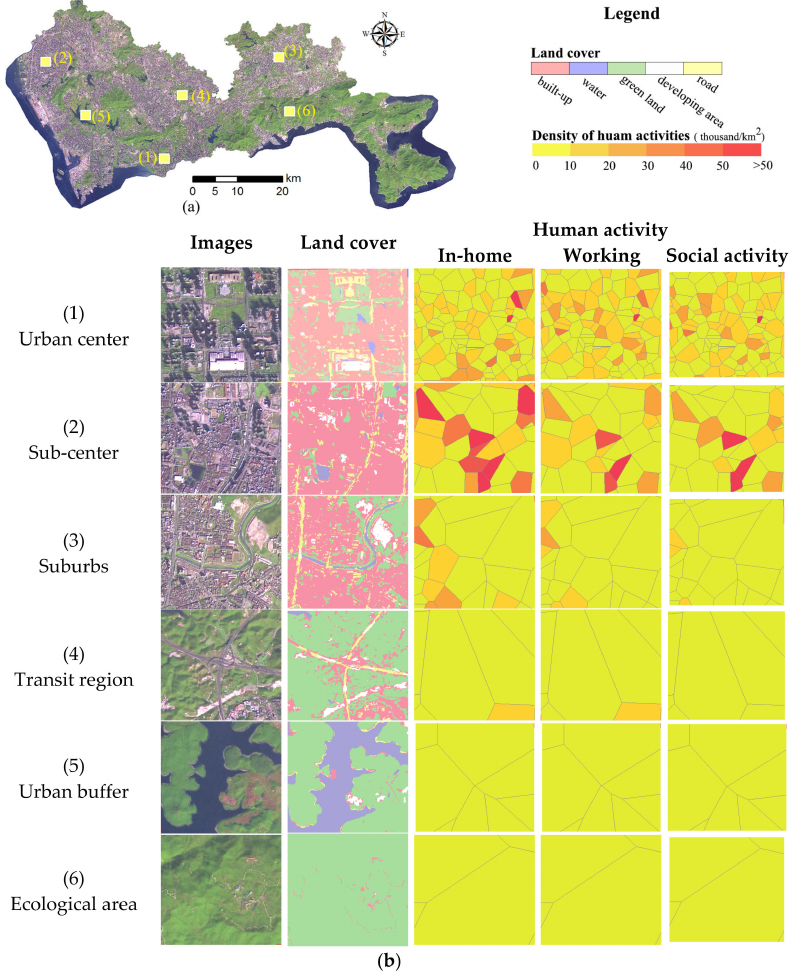
Figure 9. Representative urban cells. ( a ) Locations of urban cells; ( b ) SPOT-5 images, land cover and human